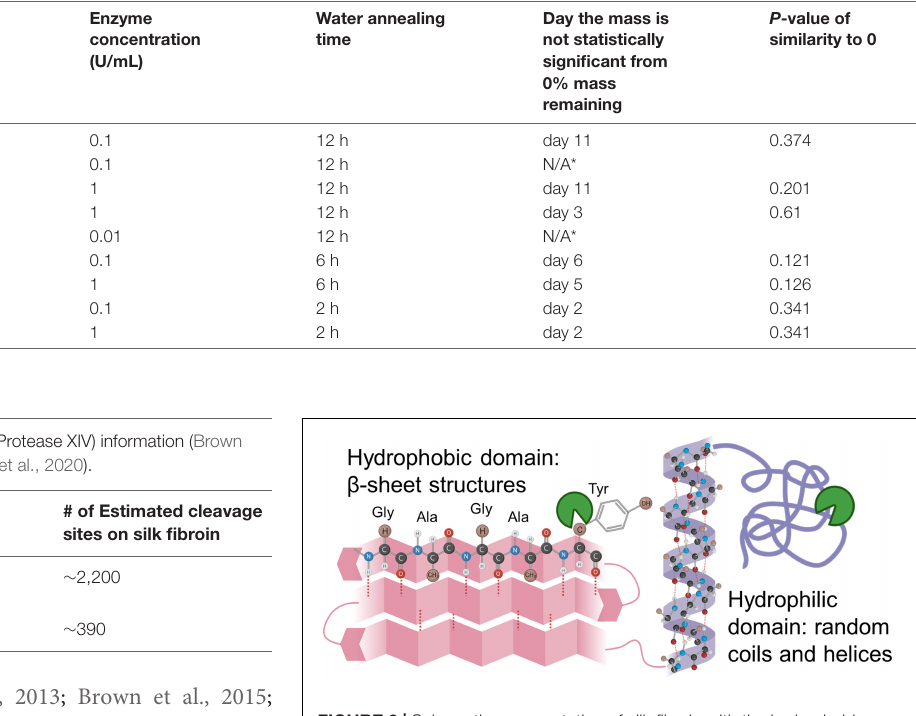
FIGURE 3 | Schematic representation of silk fibroin with the hydrophobic domain (pink) and hydrophilic domain (purple) are demonstrated here. Hydrophilic domains are hypothesized to be cleaved first and allow enzyme solution into the hydrophobic domain. Inspiration and information came from Wang et al. (2019) and Guo et al.